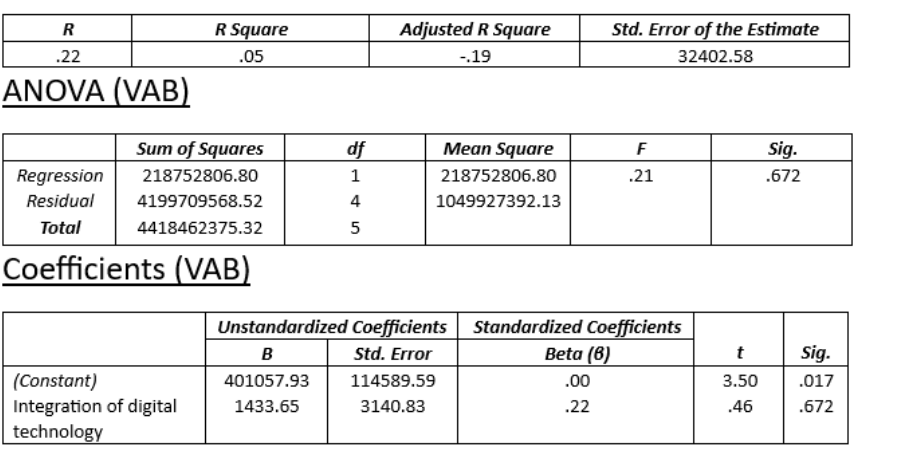
Figure 12. Linear regression: digitalization and gross value added—an average of EU states.